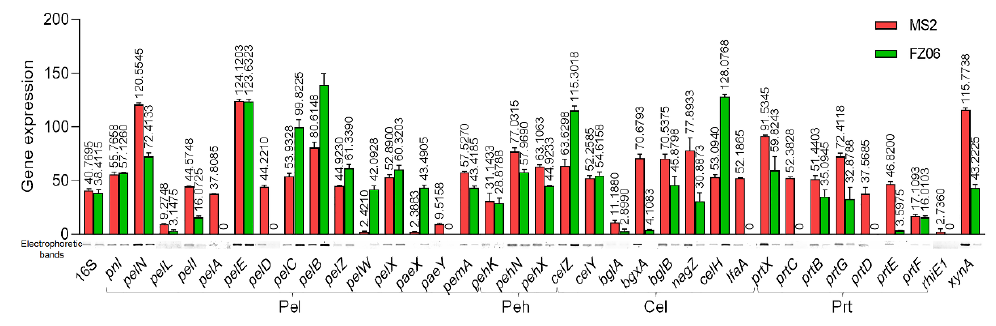
Figure 7. RT-PCR of CWDE genes of strains MS2 and FZ06 (OD 600 of 1.0). The reference gene 16S rDNA was used to equilibrate the concentration of cDNA samples. The expression of genes was determined by measuring the signal intensity of the bands (under the x axis) using Image Lab software (Bio-Rad, Hercules, CA, USA). Experiments were repeated in triplicate, and the mean data above the bars indicate the signal intensity of RT-PCR